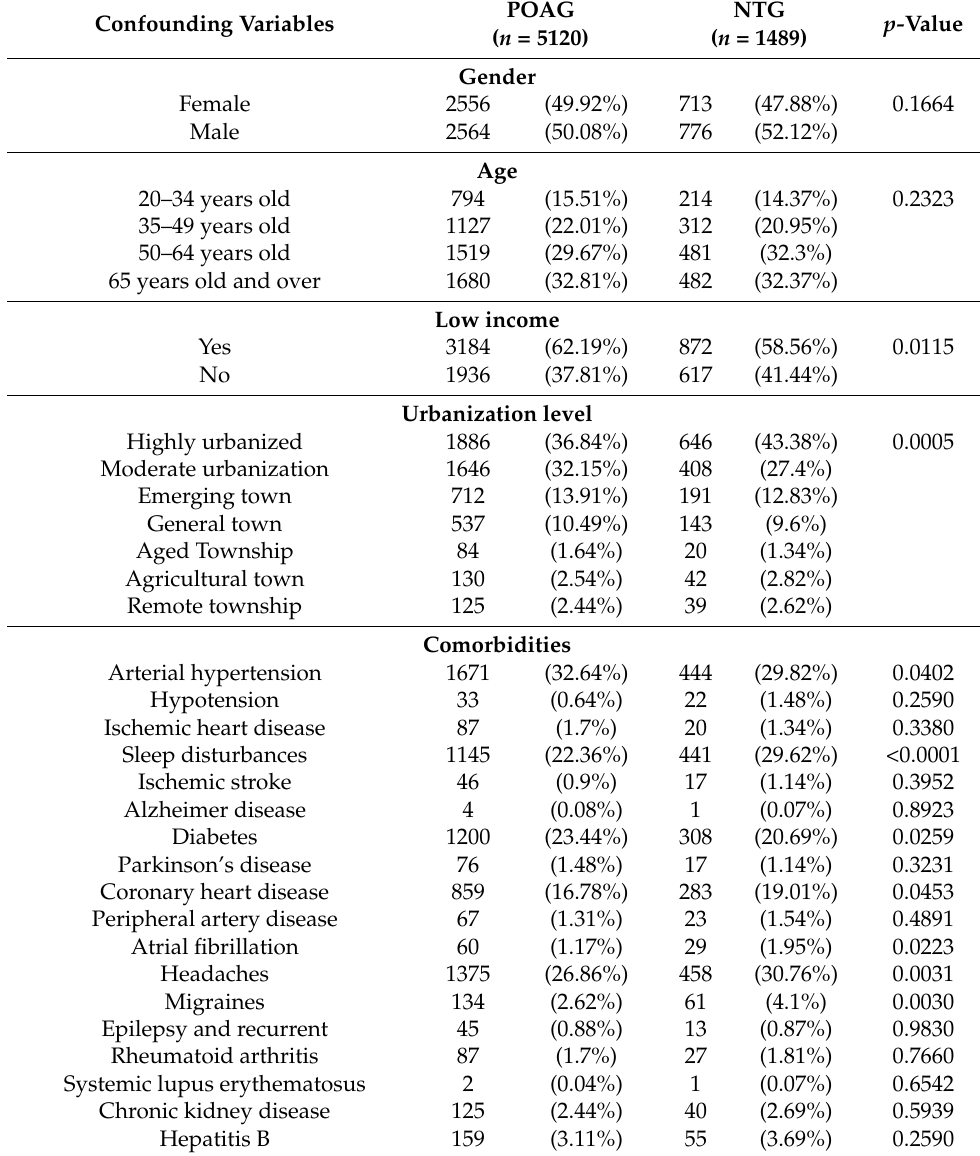
Table 1. Baseline characteristics of participants of POAG and